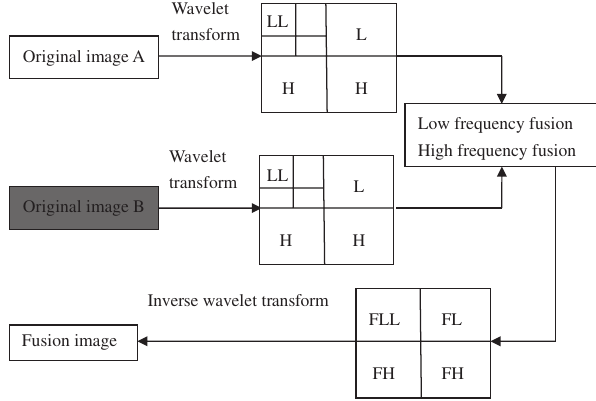
Figure 2: Framework of Image Fusion Based on Wavelet